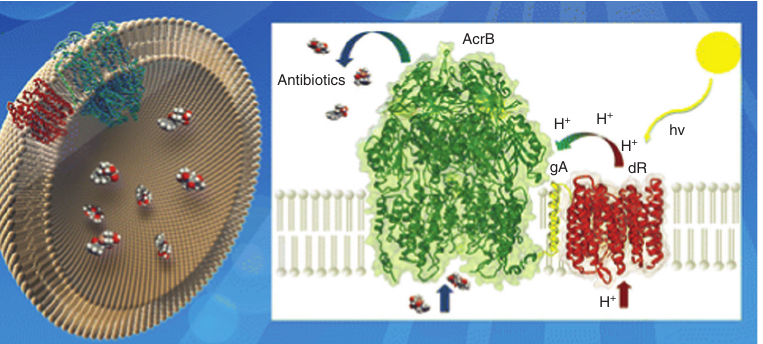
Figure 6 Engineering bacterial efflux pumps for solar-powered bioremediation of surface waters. Reprinted (adapted) with permission from [6]. Copyright (2013) American Chemical Society.